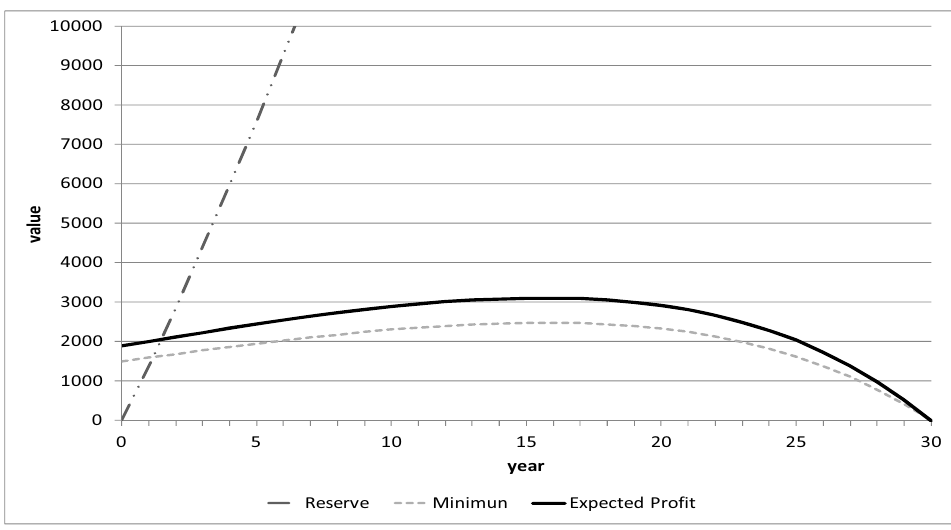
(cid:5) U and of the generation full t